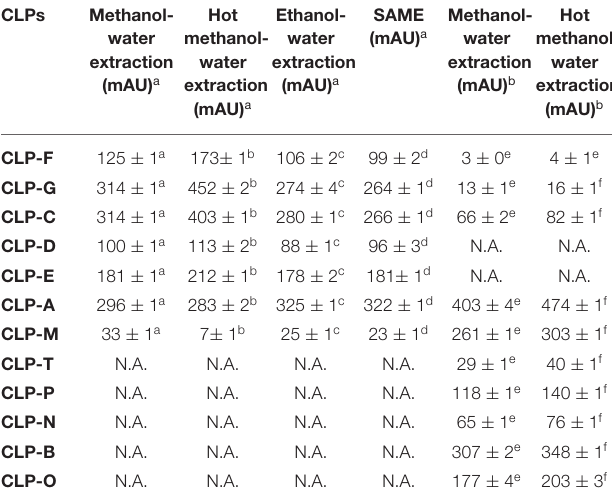
TABLE 2 | CLP extraction methods and their